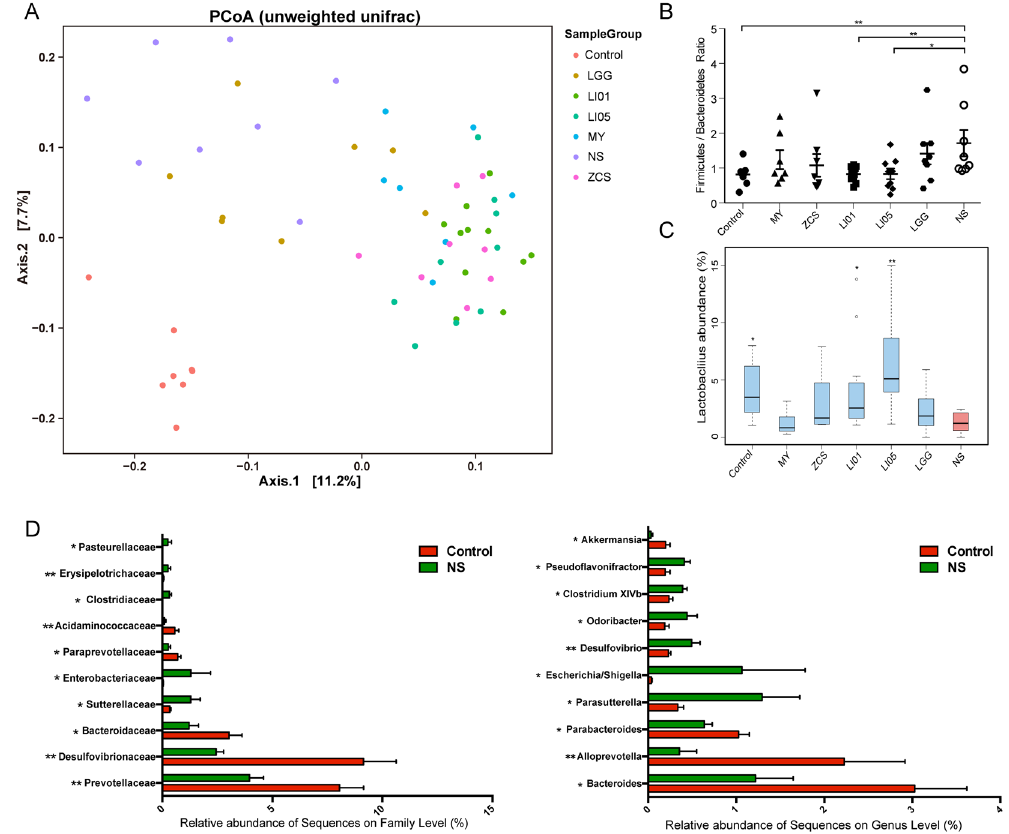
Figure 4. Comparison of the microbiome between different experimental groups. ( A ) A PCoA plot of the microbiota based on the results of the unweighted UniFrac metric. Each symbol represents a sample; the variance explained by the PCs is indicated on the axes (Unweighted PCoA; NS vs. Control, r = 0.82, P = 0.001; NS vs. LI01, r = 0.80, P = 0.001; NS vs. LI05, r = 0.81, P = 0.001). ( B , C ) The Firmicutes/Bacteroidetes (F/B) ratio and relative abundance of Lactobacillus in the Control, NS, LI01, LI05, MY, ZCS, and LGG groups. ( D ) Comparison of the ten most abundant taxa at the bacterial family and genus levels between the NS and Control groups. All data are given as the mean ± SEM. * P < 0.05 and ** P < 0.01 vs. normal saline-treated cirrhotic rats in the NS